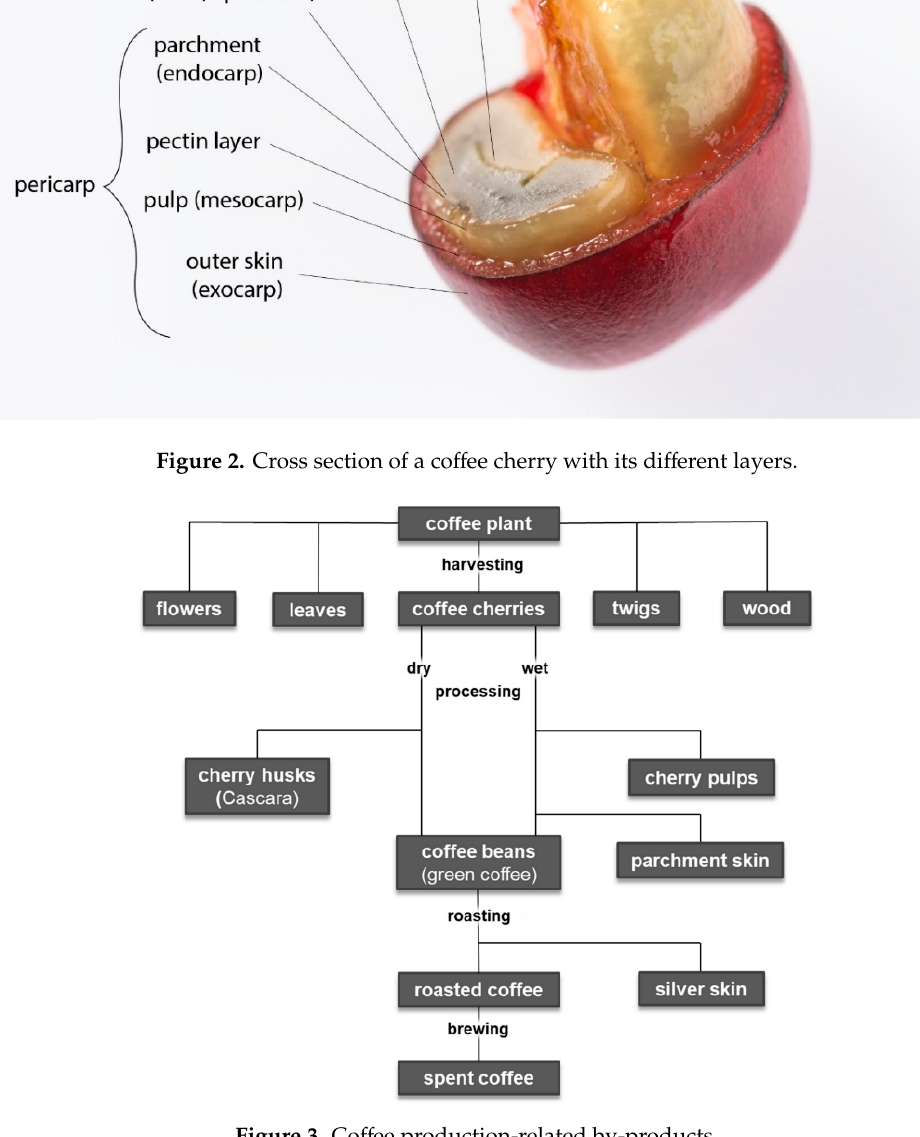
Figure 3. Co ff ee production-related Figure 3. Coffee production-related by-products. Figure 3. Coffee production-related by-products.